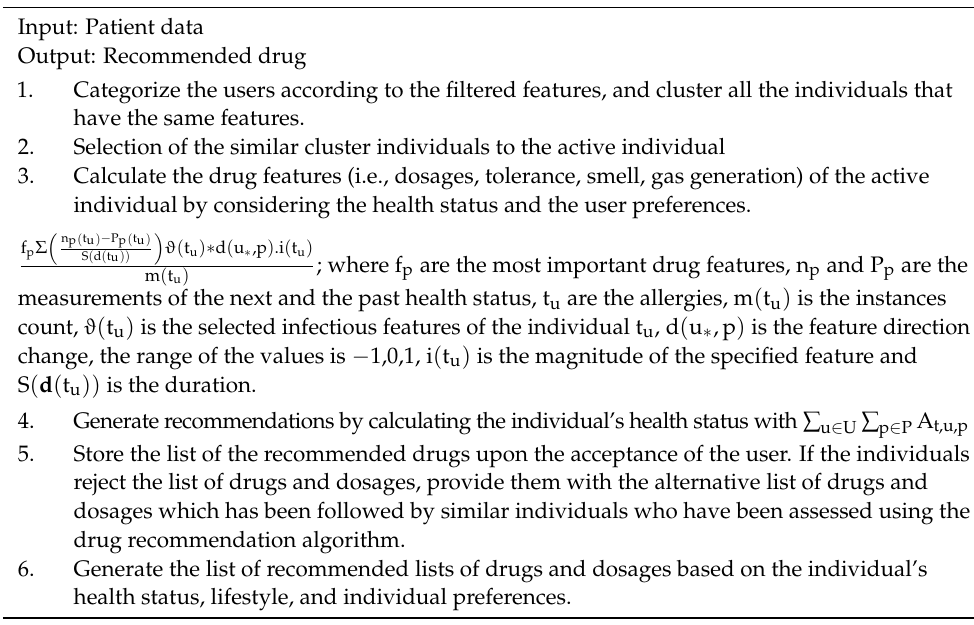
Algorithm 1. Drug recommendation algorithm